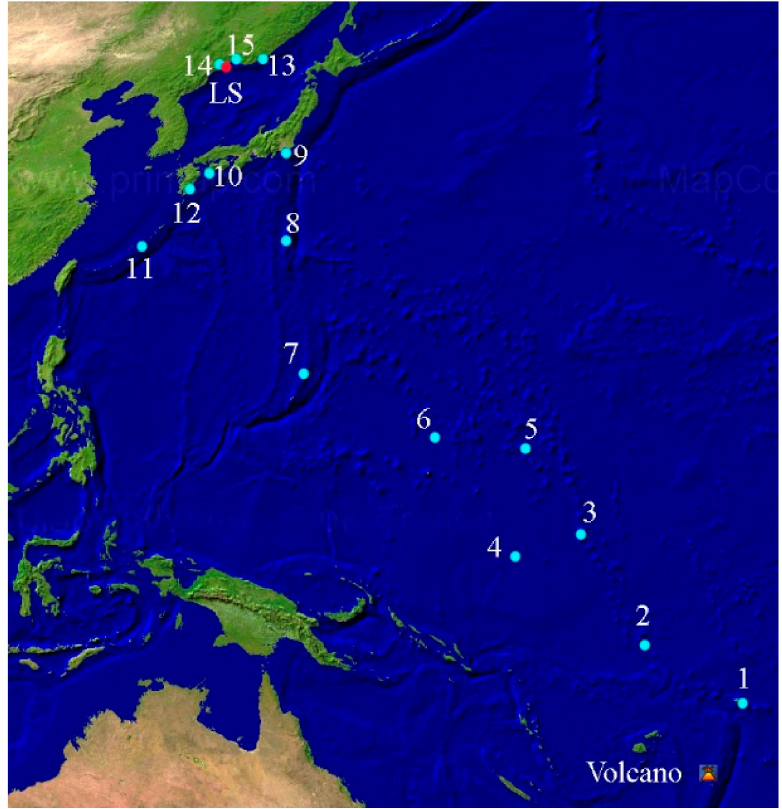
Figure 1. 1–12 show stations in the Pacific Ocean; 13–15—stations in the Sea of Japan near the coast of the Primorsky Territory of Russia. Red circles mark the location of the laser-interference receiving